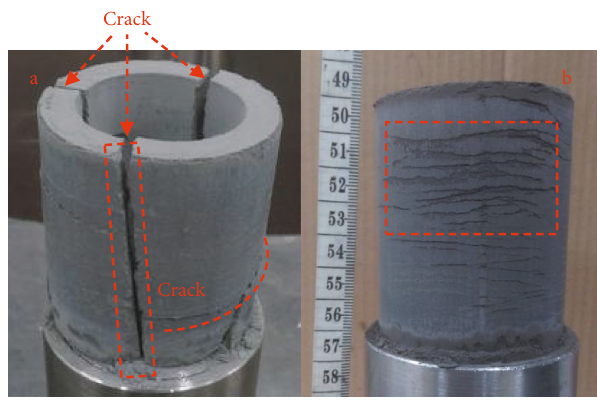
Figure 5: Oxygen candle at r � 20